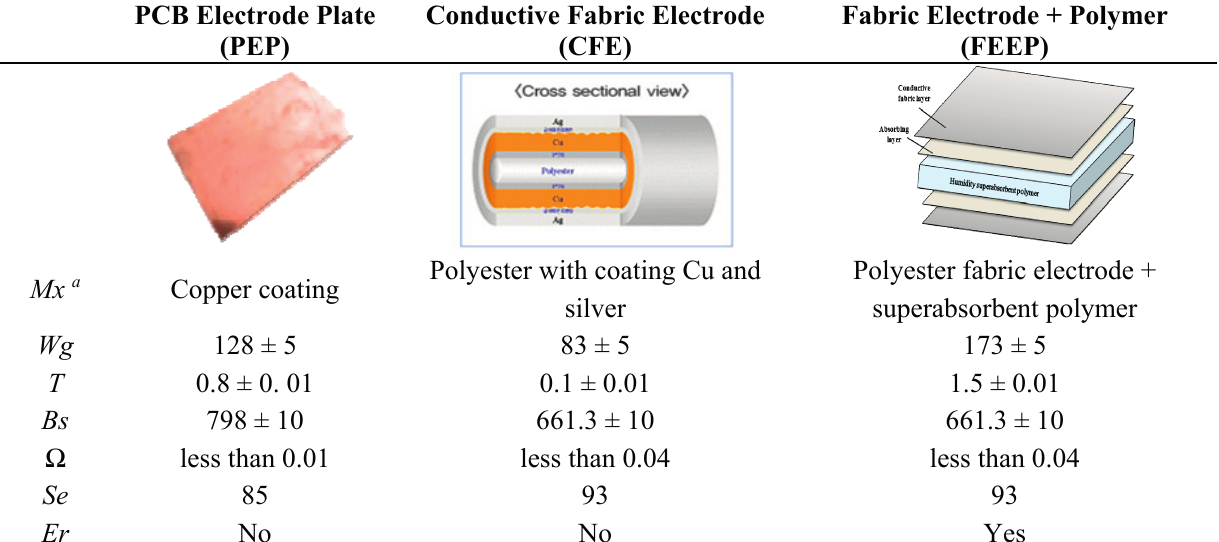
Table 1. Characteristic and specification of various sensor electrodes.